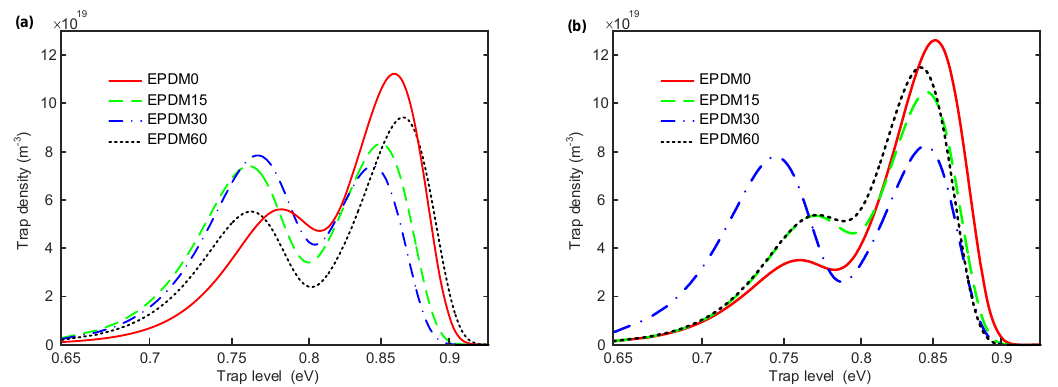
Figure 6. Surface trap distribution of samples with various fluorination time under 5 kV corona voltage. ( a ) Hole traps; ( b ) electron traps.